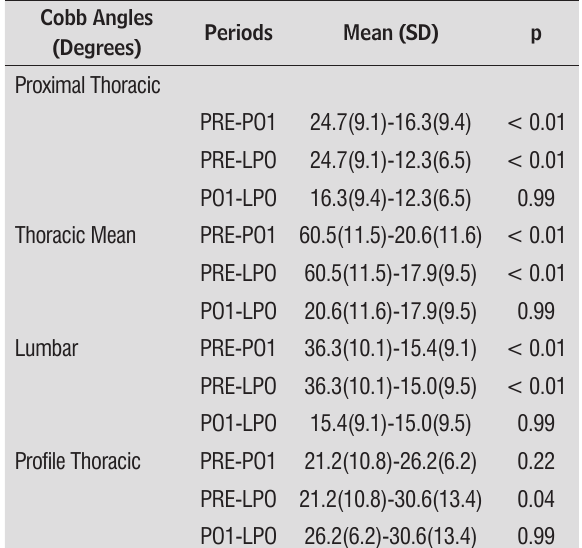
Table 3 - Comparison of Cobb angles and respiratory variables in the Preoperative (PRE), Postoperative (PO1) and Late Postoperative (LPO) periods of the 11 patients